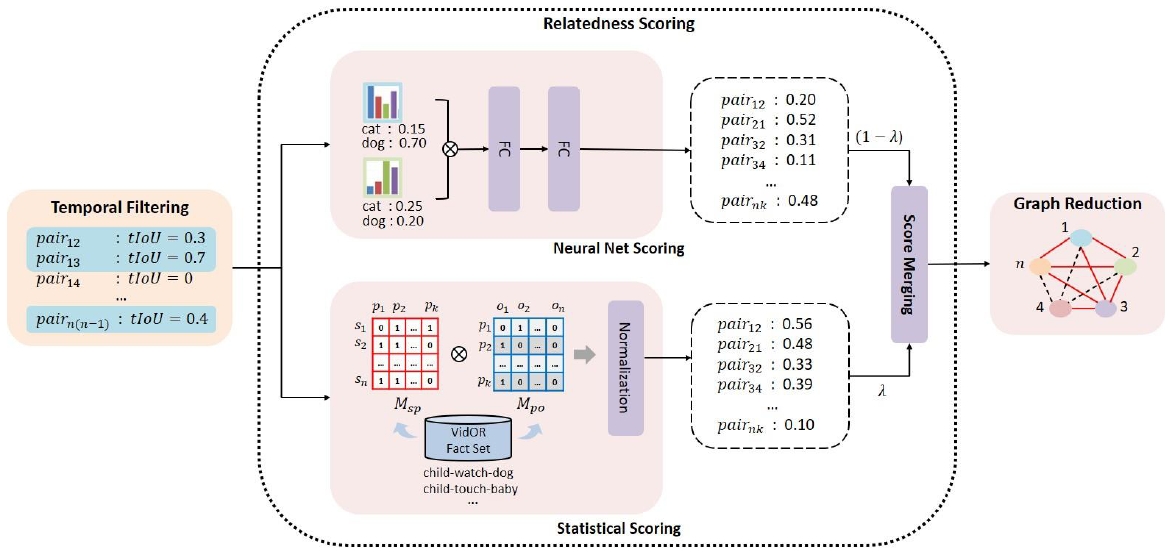
Figure 3. Tracklet pair proposal (TPP).